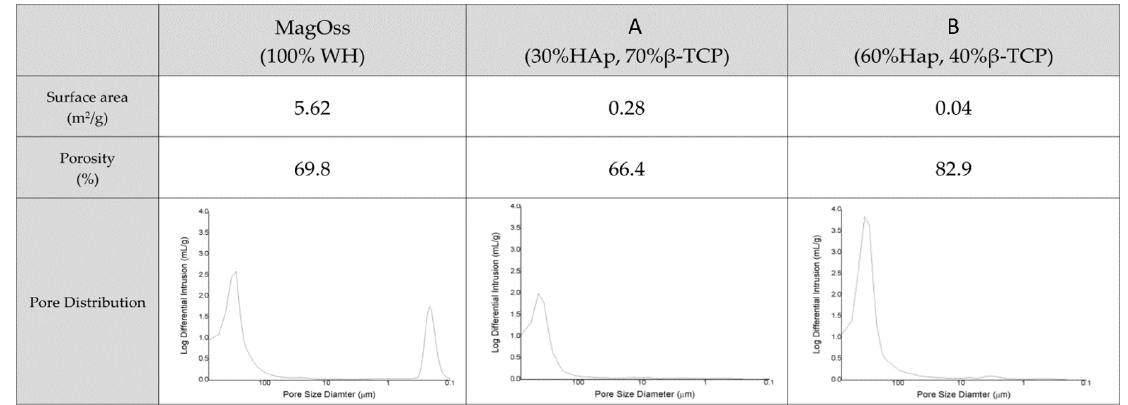
Figure 3. Surface area and pore size distributions of different bone grafts. The porosity of bone graft products was more than 60%, but nanopores (<500 nm) were only found in the MagOss group. The MagOss group exhibited the smallest grain size, which corresponds to a high surface area. The surface area was relatively low in Groups ( A , B